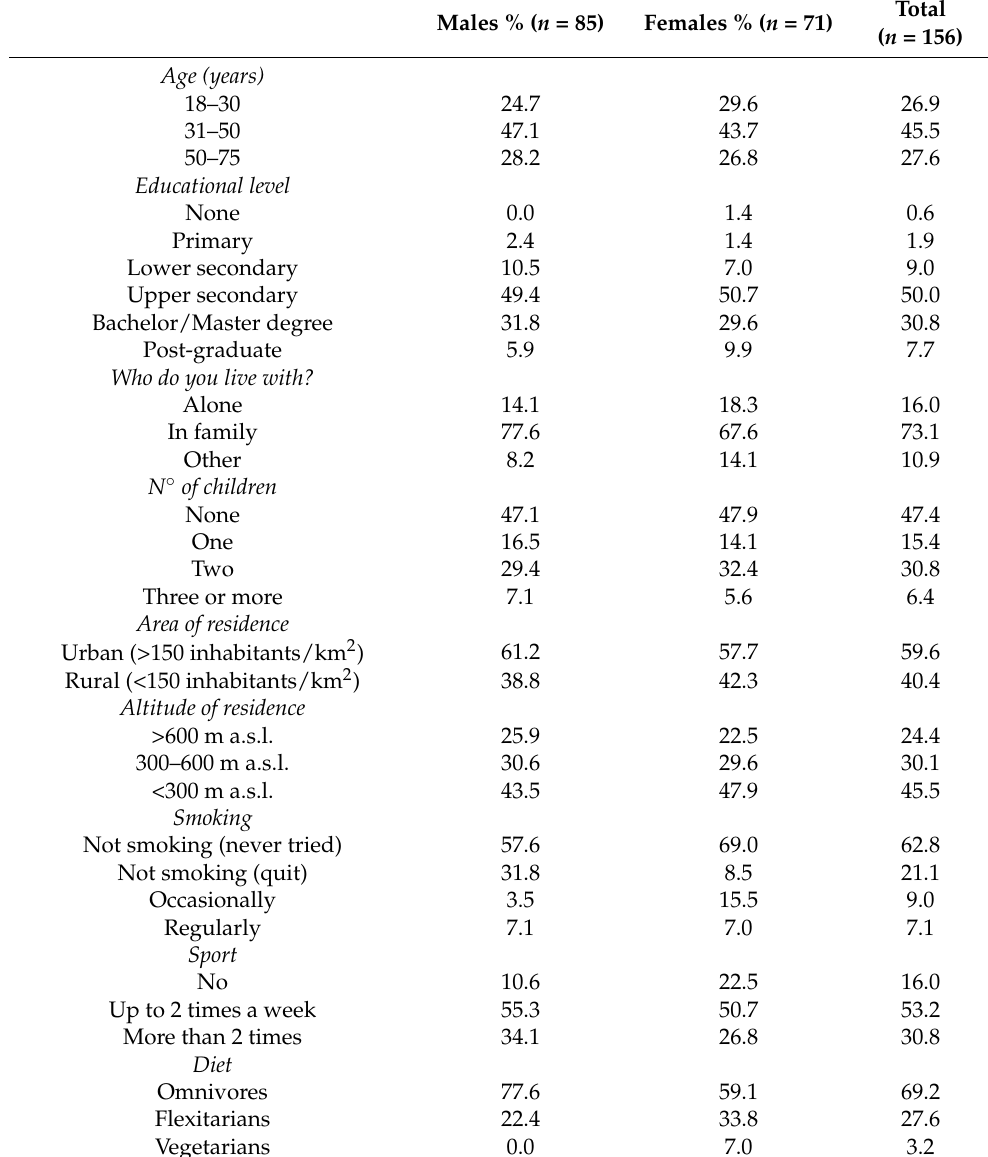
Table 5. Percentage distribution of socio-demographic characteristics by gender of respondents recruited in the consumer